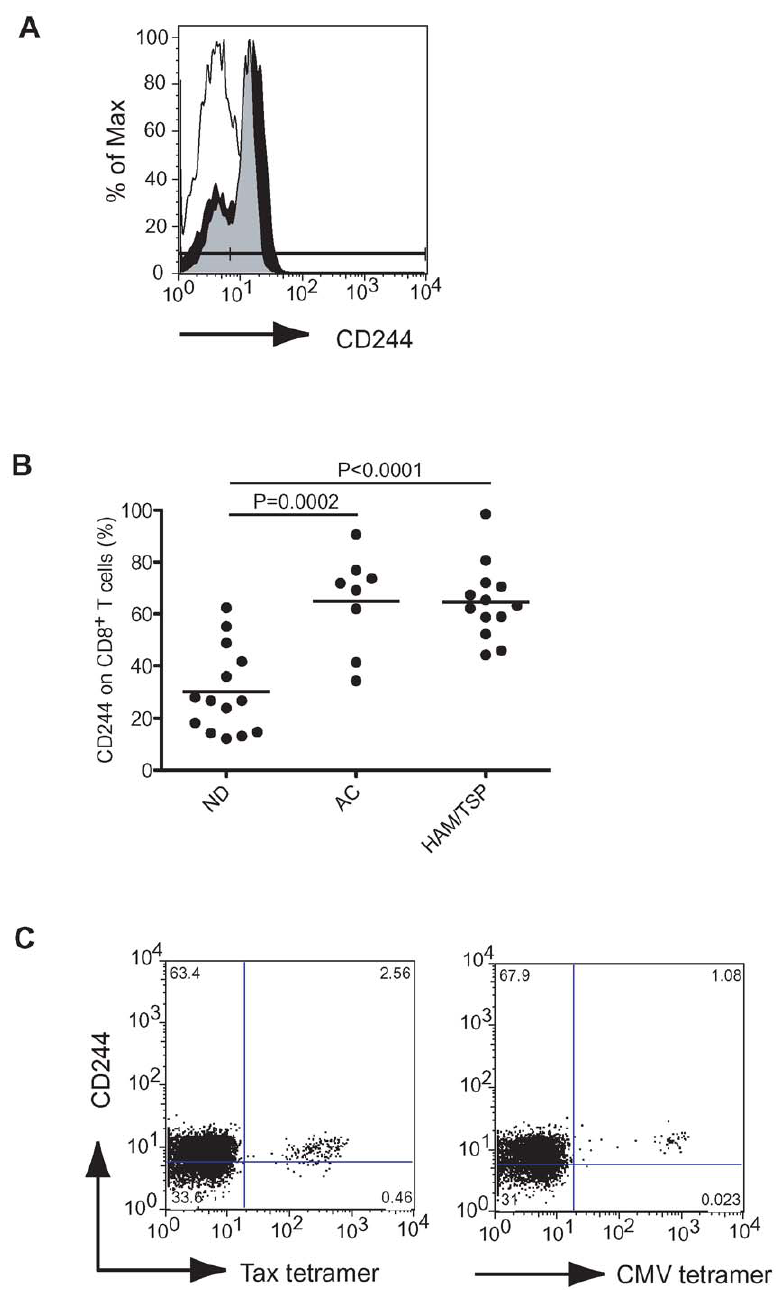
Figure 1. Expression of CD244 on CD8 + T cells of HTLV-I-infected patients. (A) Representative histograms of CD244 expression on CD8 + T cells of a ND, an AC and a patient with HAM/TSP. Staining in ND (opened histogram), AC (grayed histogram) and patient with HAM/TSP (closed histogram) were shown. (B) Comparison of CD244 expression in CD8 + T cells of NDs and HTLV-I-infected patients. The data were obtained from 14 NDs, 8 ACs and 13 patients with HAM/TSP. The horizontal line represents the median. (C) CD244 expression on antigen-specific CTLs. CD244 expressions were shown in Tax11-19- specific and CMVpp65-specific CD8 + T cells of a patient with HAM/TSP.